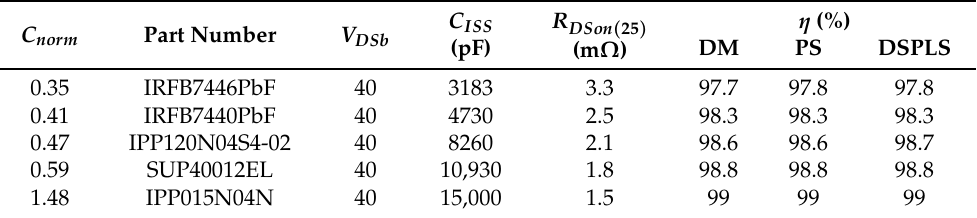
Table 9. Comparison of optimal solutions with same part number for all MOSFETs with each modulation technique, with 800 W. Reference values: C ref = 1, η ref = 98.23.